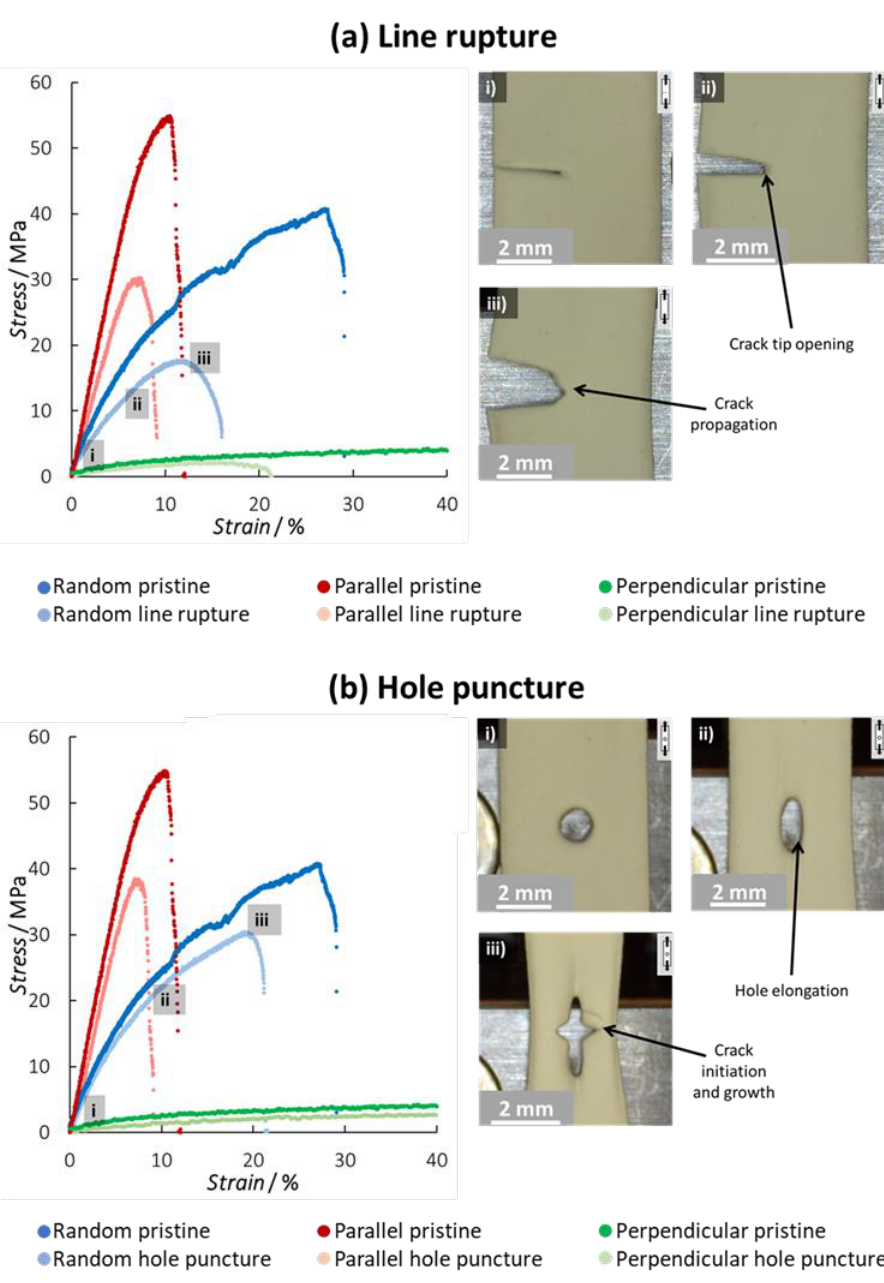
Figure 5. ( a ) Overview of representative tensile tests on nanofiber membranes with a line rupture, combined with images of the progressive failure stages of a random nanofiber membrane. ( b ) Overview of representative tensile tests on nanofiber membranes with a hole puncture, combined with images of the progressive failure stages of a random nanofiber membrane. Figures ( i – iii ) show the deformation of the membrane at different stages of the stress – strain curve. Similar deformation behavior is observed for the samples with parallel and perpendicular aligned nanofibers (see Figures S2 and S3 in the Supporting Information). Table 2. Ultimate tensile strength for pristine and damaged nanofiber membranes.